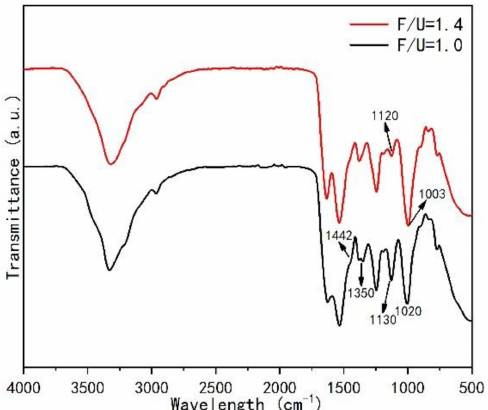
Figure 12. Comparison of Fourier infrared spectrometer analysis (FT-IR) spectra of UF resins with molar ratios of 1.4 and